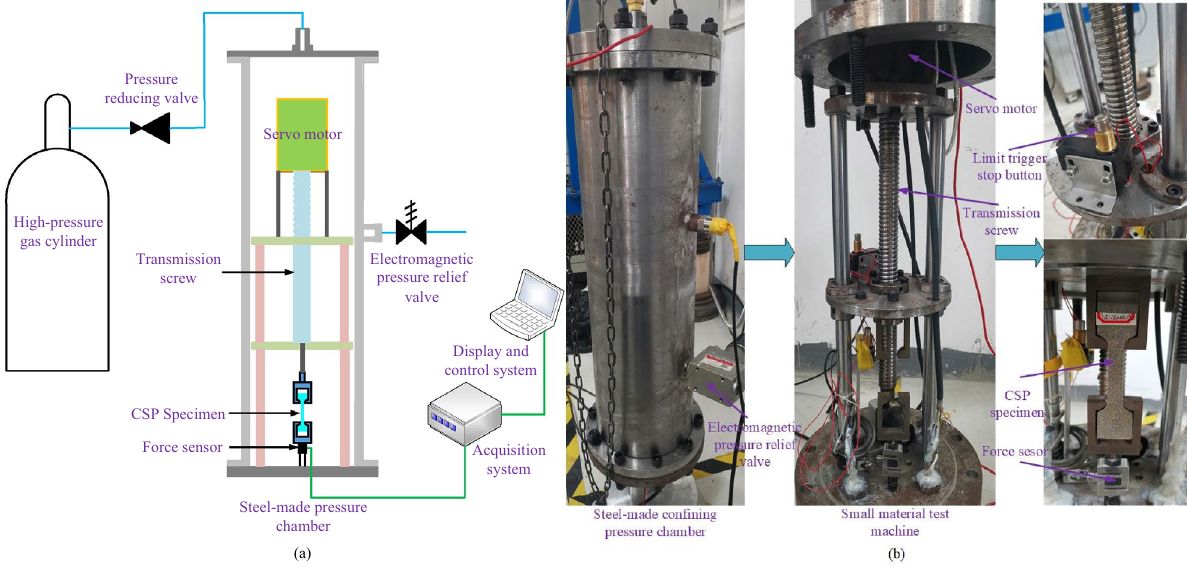
Figure 5. New active confining pressure experimental system. ( a ) Schematic diagram and ( b ) actual